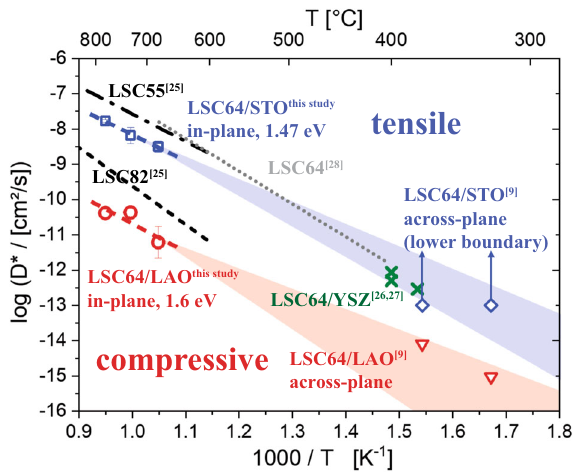
Fig. 5 Arrhenius-type plot of the tracer diffusion coef fi cient D * measured for different LSCO types. Blue: tensile epitaxial LSCO64 thin fi lms: this study and ref. 9 . Red: compressive epitaxial LSCO64 thin fi lms: this study and ref. 9 . Green: columnar polycrystalline LSCO64 thin fi lms 26, 40 , black- gray: bulk LSCO 41 . The error bars show the standard deviation for the